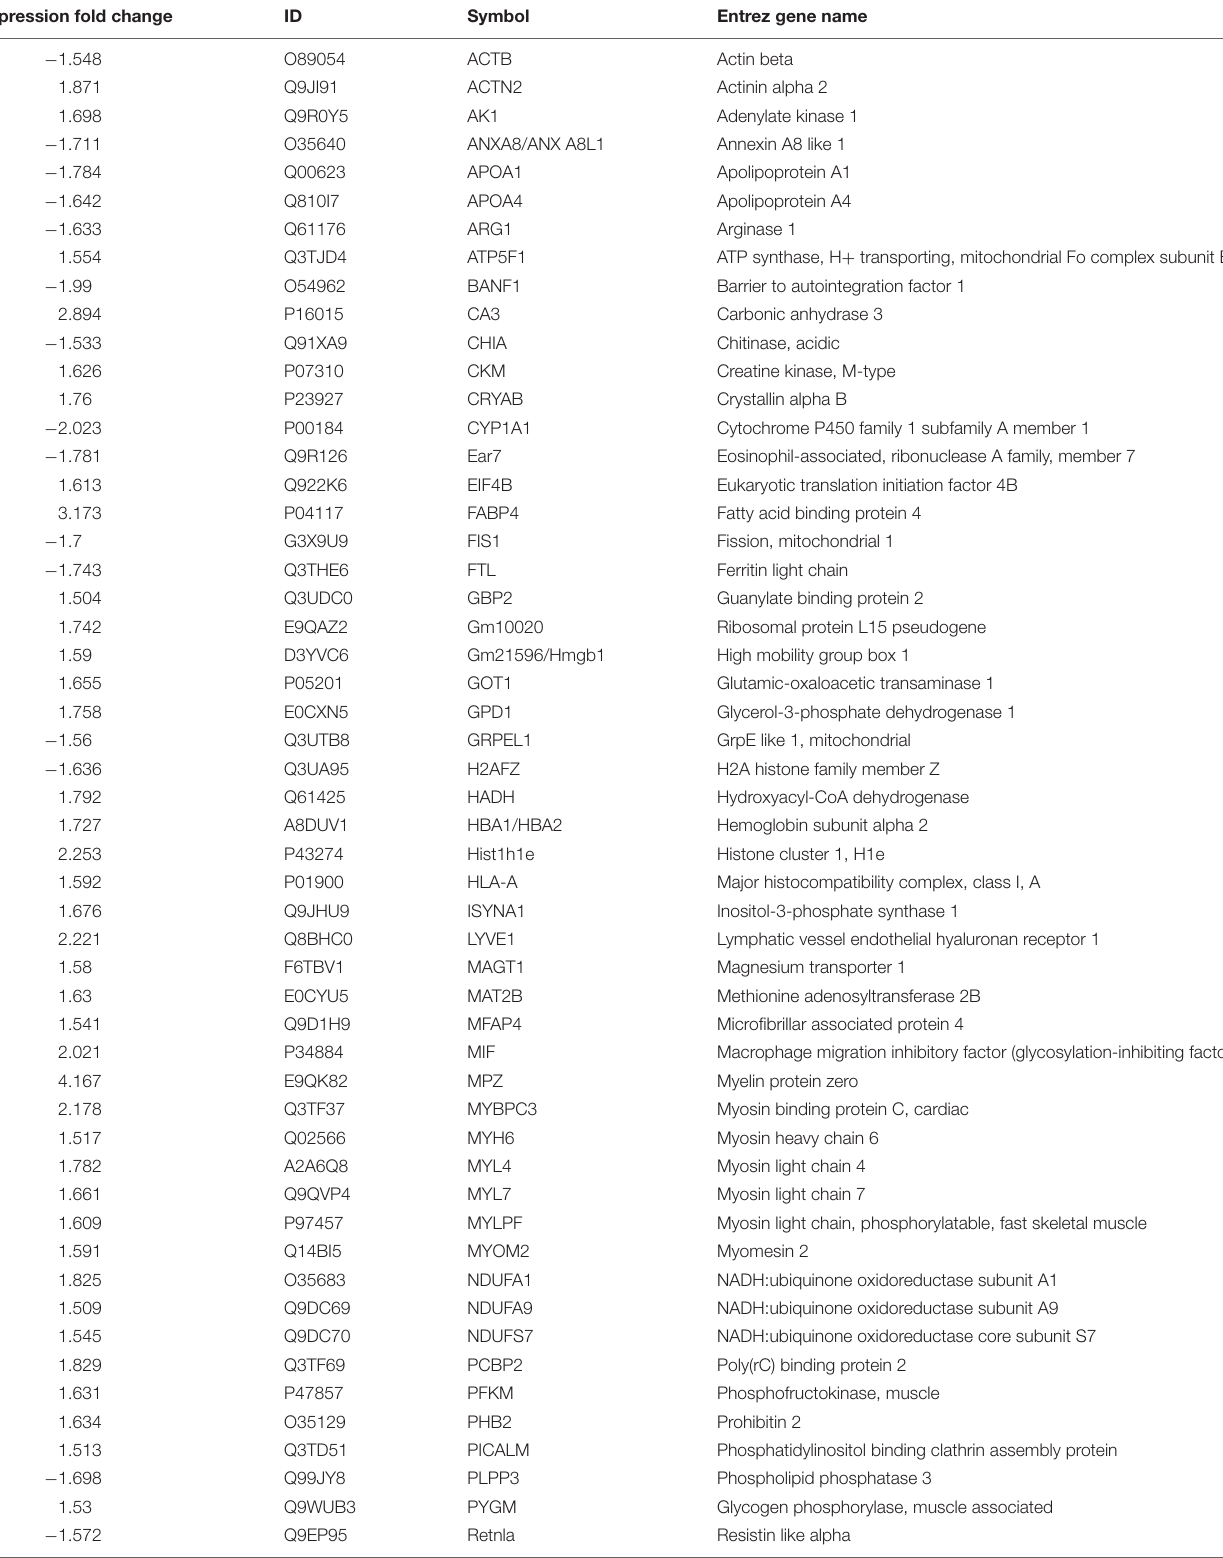
TABLE 5 | DEPs in the GBF group compared with the MOD group. Expression fold